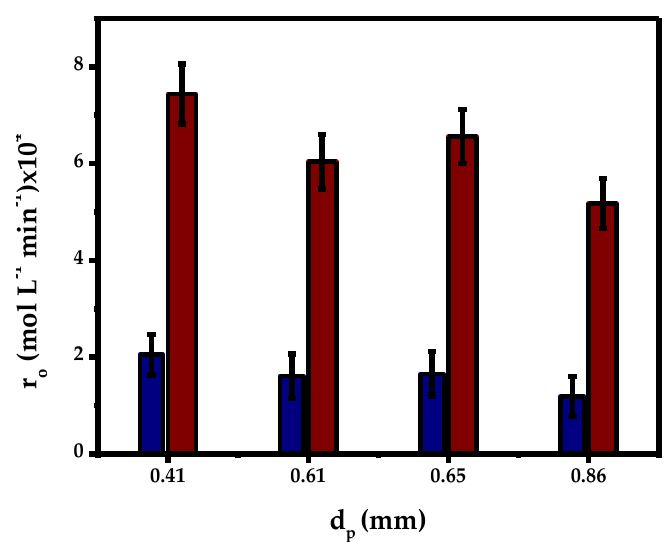
Figure 4. Internal mass transfer in the esterification of ibuprofen: initial reaction rate vs. particle diameter for 50 ◦ C (blue) and 70 ◦ C (red). Operational conditions: T = 50 and 70 ◦ C, C I0 = 60 g · L − 1 , C E = 30 g · L − 1 , N = 720 rpm.